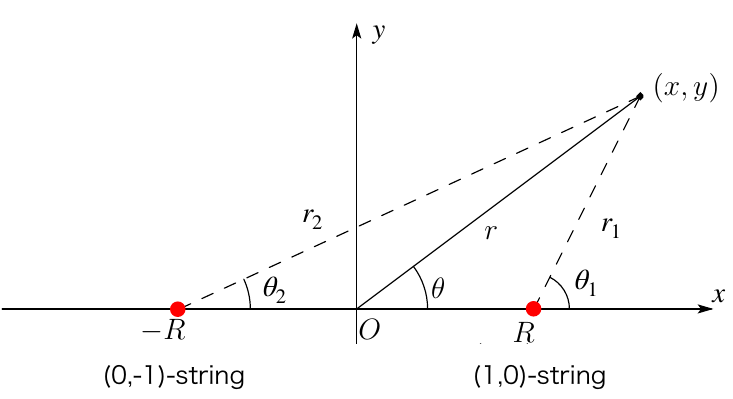
FIG. 2: Configuration of (1 , 0)-vortex and (0 , 1)-vortex. Figure 2